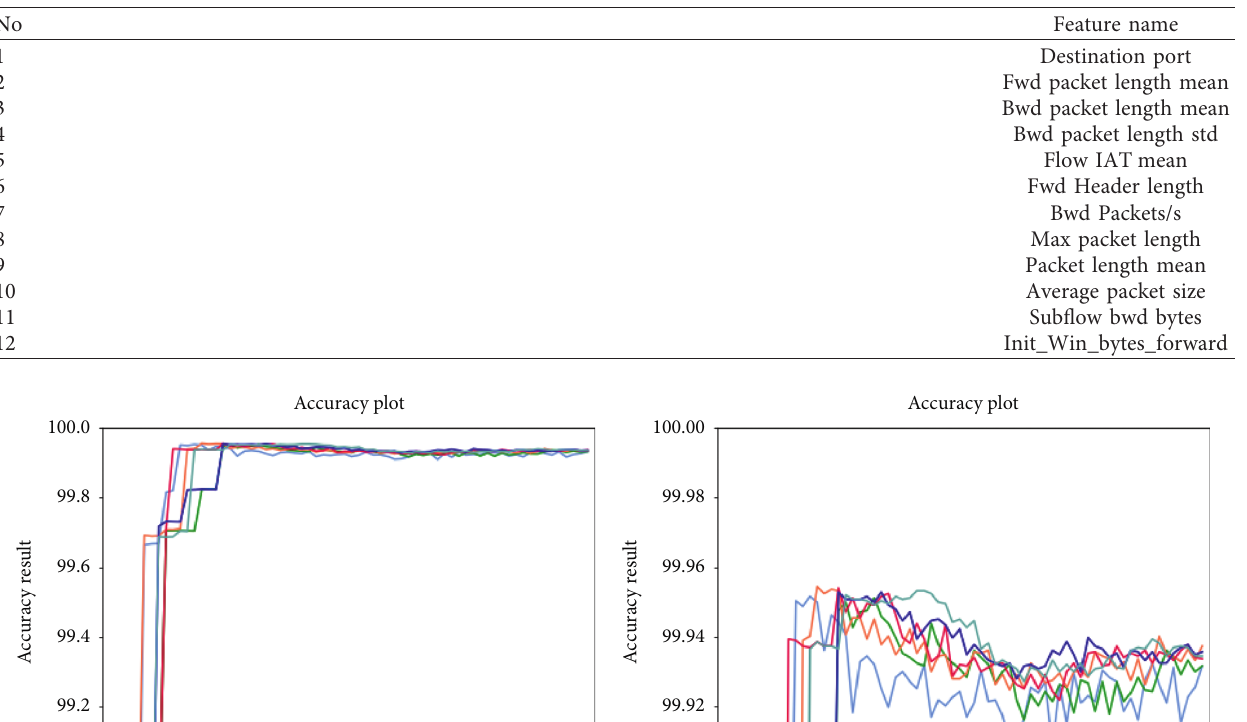
Table 6: Features selected by the best performing RF estimator.